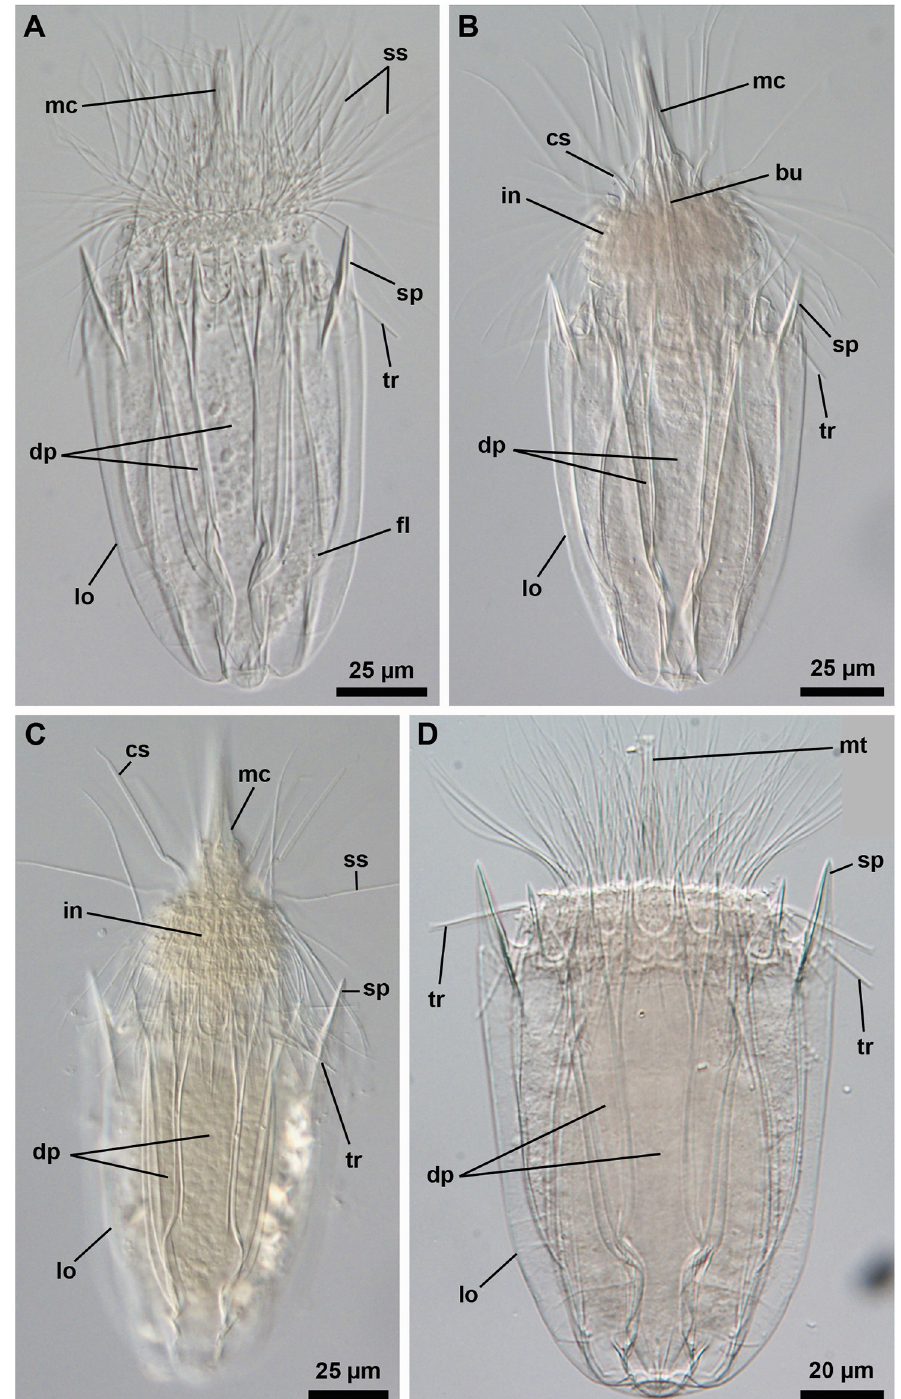
Fig 20. Light micrographs of four paratypic postlarvae belonging to genus Nanaloricus . Anterior faces up in all aspects. All specimens characterized by a dorsal plate divided into three subplates. (A and B) Postlarvae tentatively assigned to Nanaloricus valdemari sp. nov. (C and D) Postlarvae tentatively assigned to Nanaloricus mathildeae sp. nov. Abbreviations: bu, buccal tube; cs, clavoscalids; dp, dorsal plate; fl, flosculi; in, introvert; lo, lorica; mc, mouth cone; mt, mouth tube; sp, anterior spike; ss spinoscalid; tr, trichoscalid.